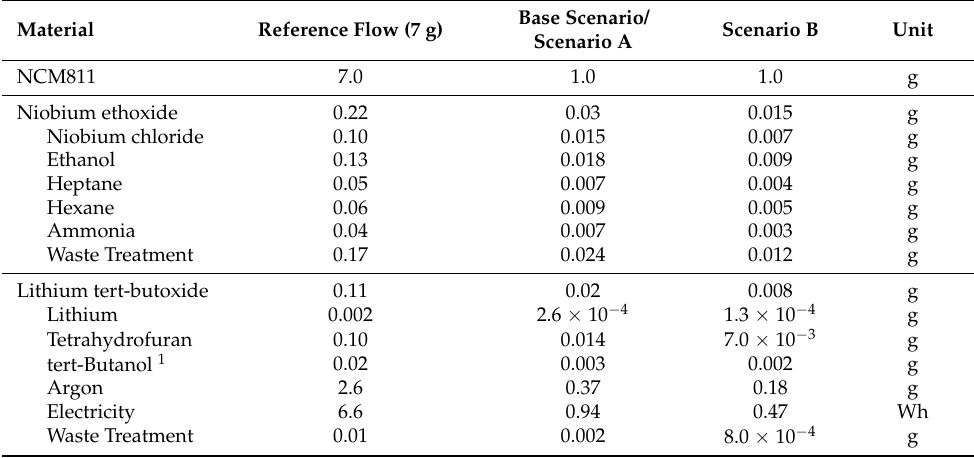
Table 7. LCI data for the ALD Process Scenarios